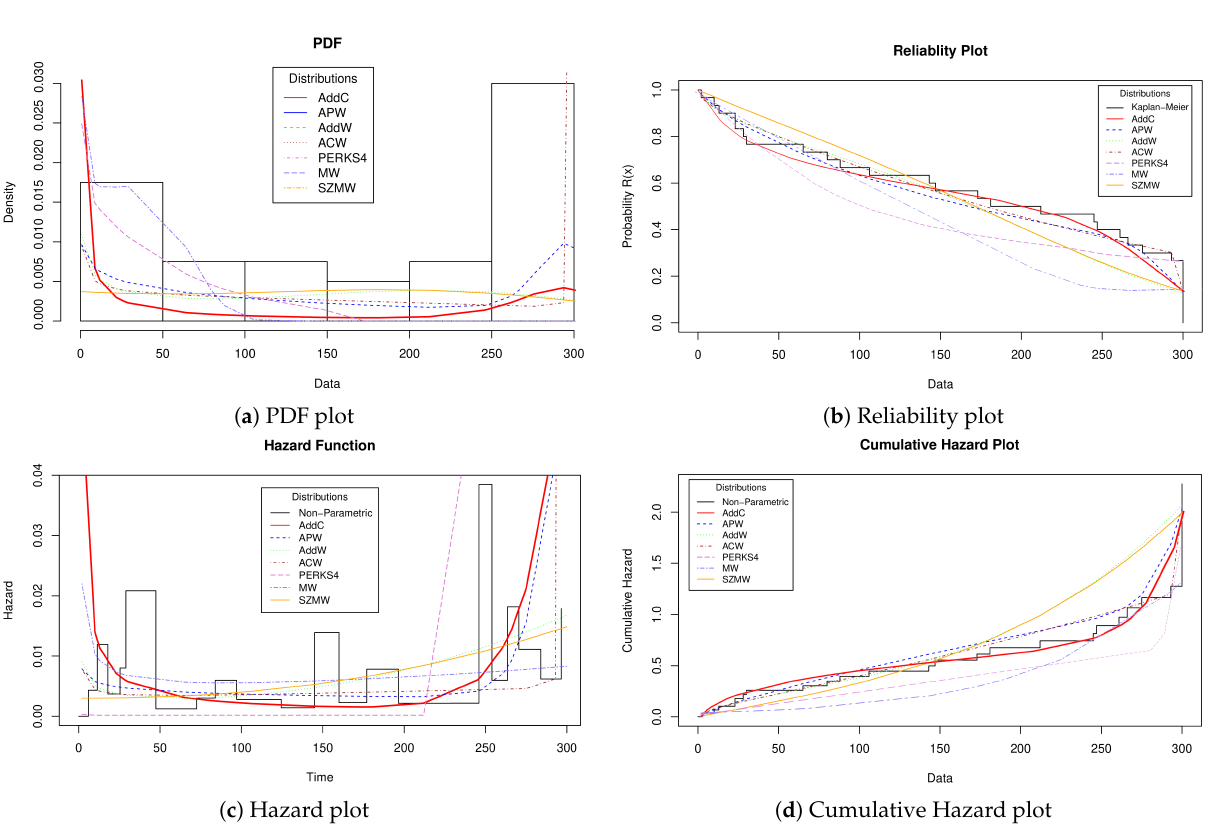
Figure 6. Reliability Plots for Lifetime data presented in Table